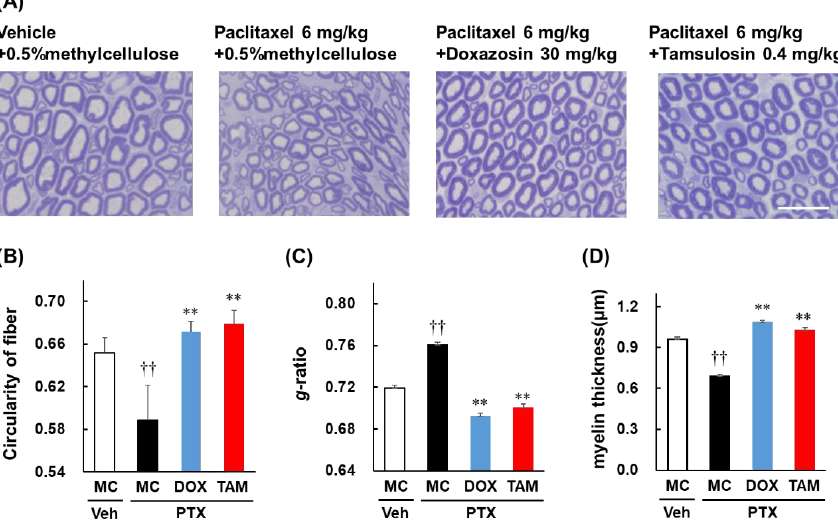
Figure 2. Effects of doxazosin (DOX) and tamsulosin (TAM) on axonal degeneration and myelin sheath damage of the sciatic nerve induced by paclitaxel (PTX) in rats. The sciatic nerve was harvested on day 28 and stained with toluidine blue. Images (shown in A ) have been magnified 40 × (bar = 25 µ m). Fiber circularity ( B ), g-ratio ( C ), and myelin sheath thickness ( D ) were analyzed using ImageJ (version 1.53) software. These results have been presented as mean ± S.E.M. †† p < 0.01 vs. vehicle + 0.5% methylcellulose, ** p < 0.01 vs. paclitaxel + 0.5% methylcellulose; one-way ANOVA followed by a Tukey–Kramer test.